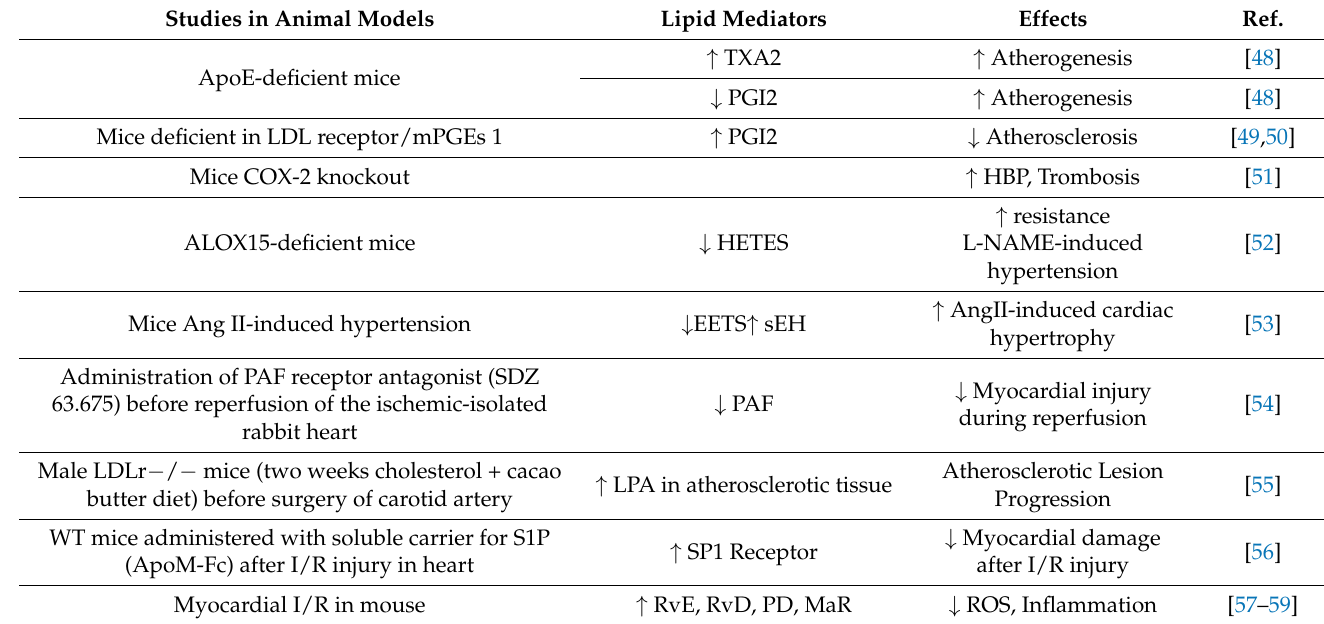
Table 1. Studies of Class 1,2,3 lipid mediators in animal